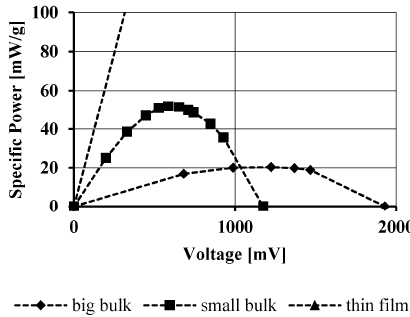
Figure 10. Details of the lower curves shown in Figure 9 under same conditions.